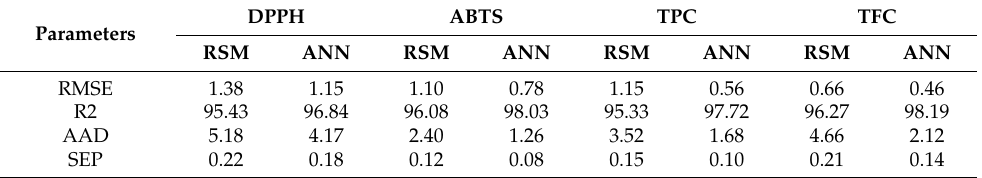
Table 3. Comparison of the prediction abilities of the RSM and ANN models.